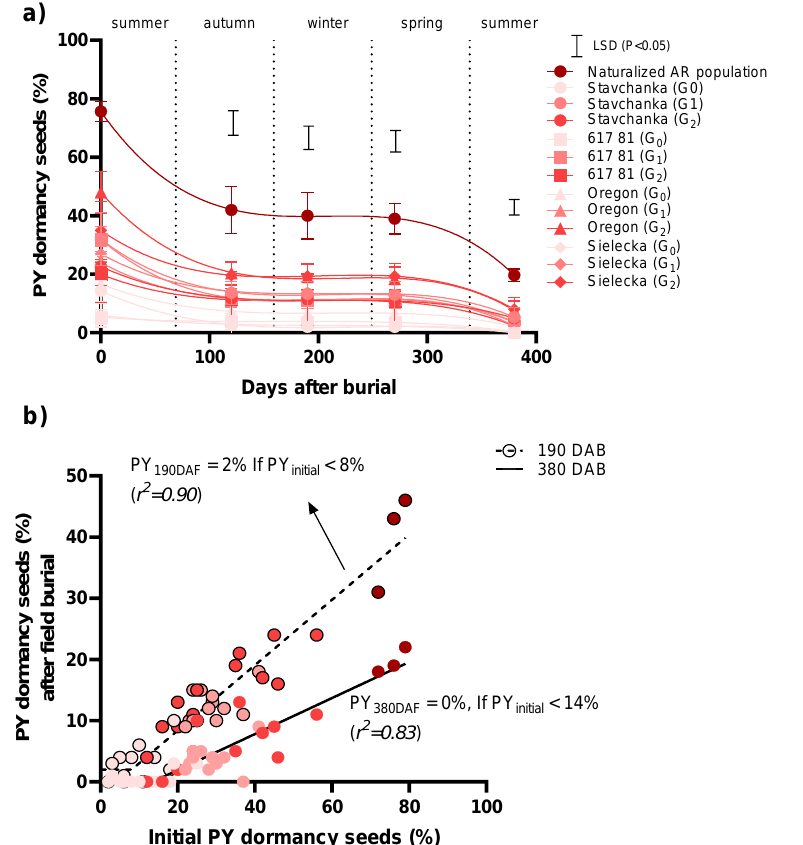
Figure 3. Percentage of physically dormant (PY) seeds for different genotypes and generations of hairy vetch as a function of days after burial (DAB) in field conditions during the 2019 growing season ( a ), and relation between PY at 190 and 380 days after field burial and initial PY ( b ). Naturalized AR showed higher dry matter production compared to EU cultivars (1229 ± 258 vs. 931 ± 311 g plot − 1 ; p < 0.01), but this difference was not observed as the generation of spontaneous crosses progressed ( p > 0.05). DM was slightly related to increases in PY levels (Figure 4).